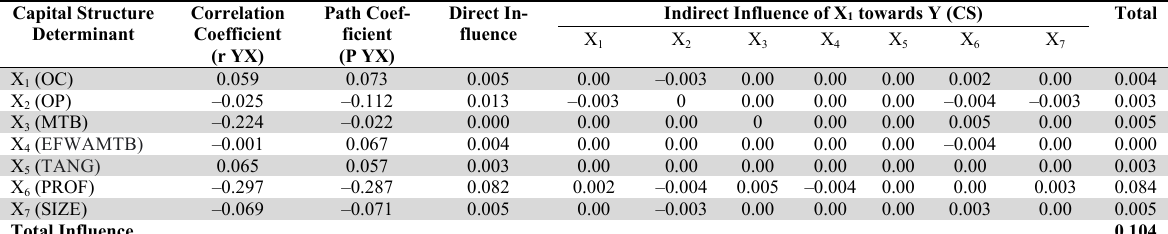
Influence of Selected Capital Structure Determinants on Capital Structure (CS) Capital Structure Determinant